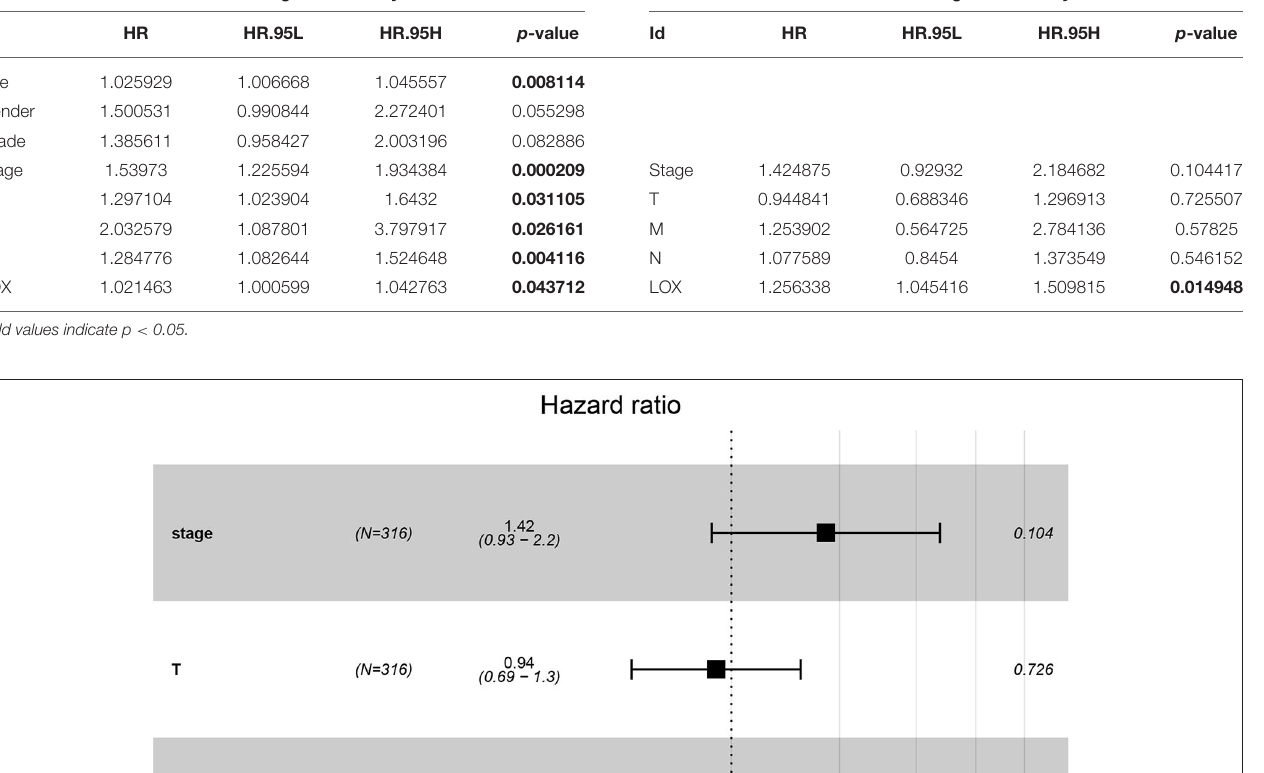
TABLE 3 | Univariate analysis and multivariate analysis of the correlation of LOX expression with overall survival among patients with gastric cancer. Univariate cox regression analysis